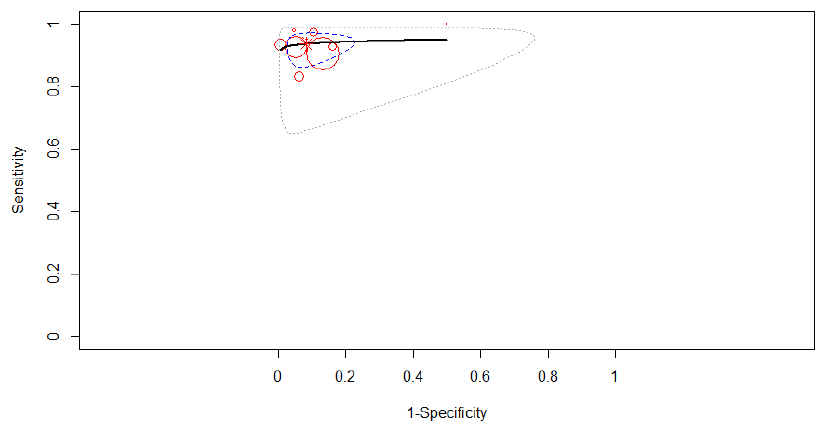
Figure 4. The SROC curve for AI. Dotted blue curve: 95% confidence region. Dotted closed curve: 95% prediction region for AI.